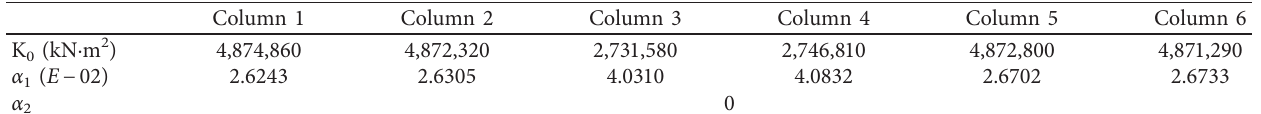
Table 19: Stiffness and reduction factor of